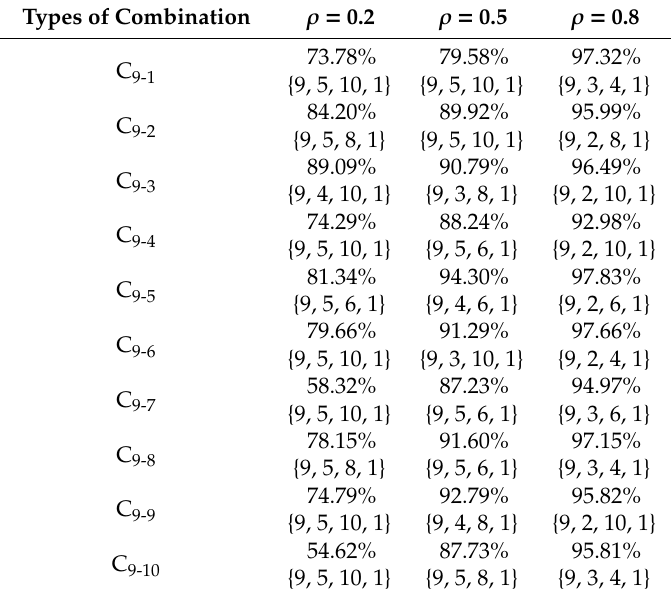
Table 3. TDNN identification results, AIR- TDNN {TD ni , TD nd , TD nh , TD no }, for ten combinations of faults of an MNP 9.